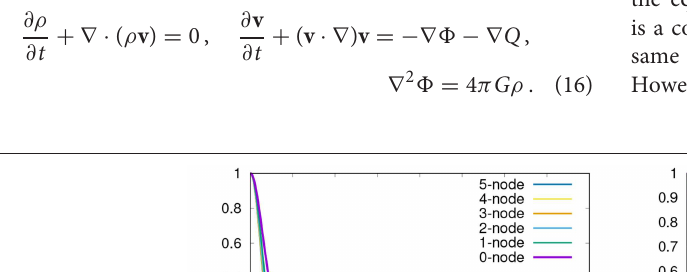
Frontiers in Astronomy and Space Sciences |